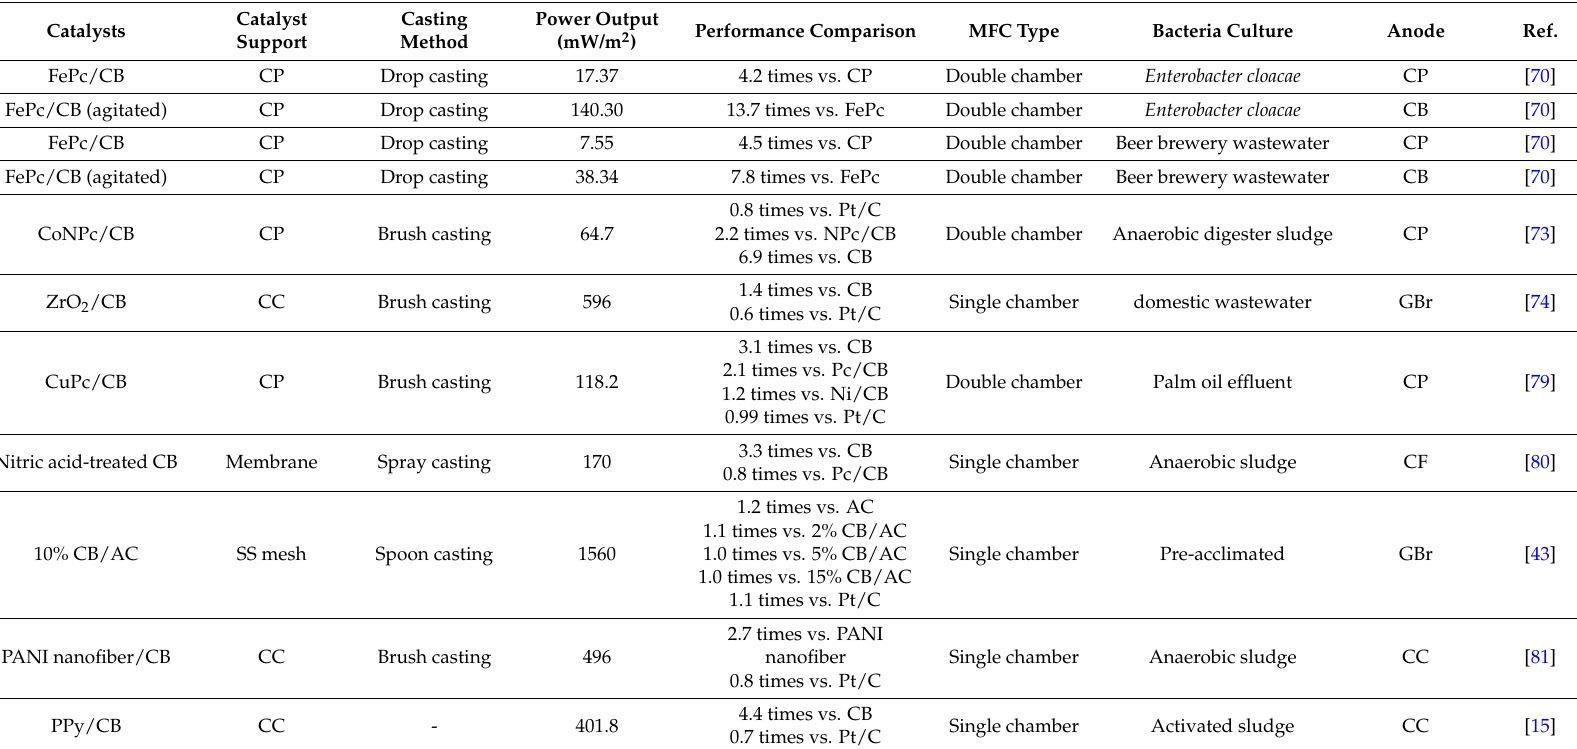
Table 1. Summary of the performance of different MFCs run using cathode materials fabricated with CB in the composite with other oxygen reduction reaction (ORR)